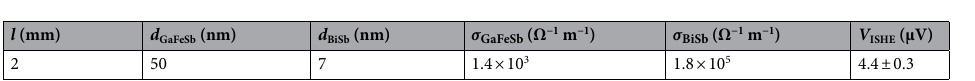
Table 1. Parameters used for the ISHA estimation. l is the distance between the gold wire contacts, d GaFeSb and d BiSb are the thickness of the (Ga,Fe)Sb layer and the BiSb layer, respectively. σ GaFeSb and σ BiSb are the electrical conductivities of the (Ga,Fe)Sb layer and the BiSb layer estimated from transport measurements, respectively. V ISHE (= V sym ) is the ISHE voltage signal estimated by the maximum peak height of the symmetric component of the voltage signal after removing the offset value. All parameters are estimated at 300 K, at a microwave power of 200 mW with a magnetic field H direction of θ H = 90° ( H // [ 110 ]